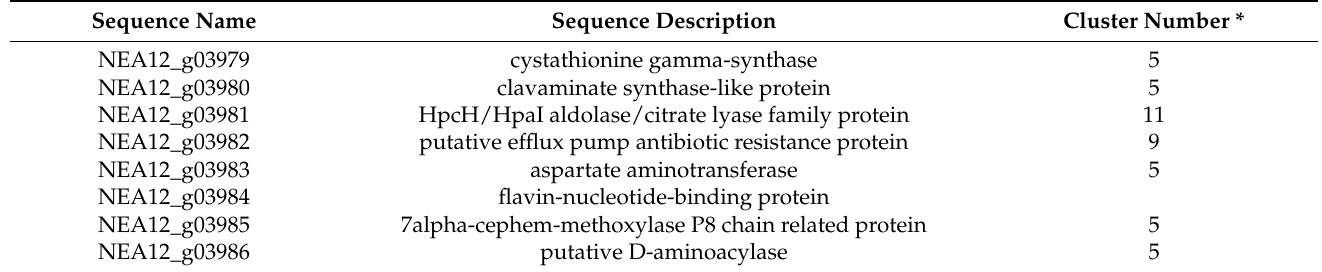
Table 3. Predicted functions and cluster numbers of a putative novel biosynthetic gene cluster in